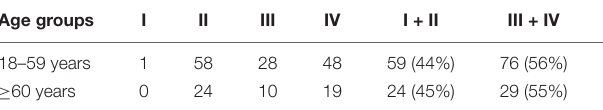
TABLE 4 | Distribution of PTA after treatment of 1 month (two